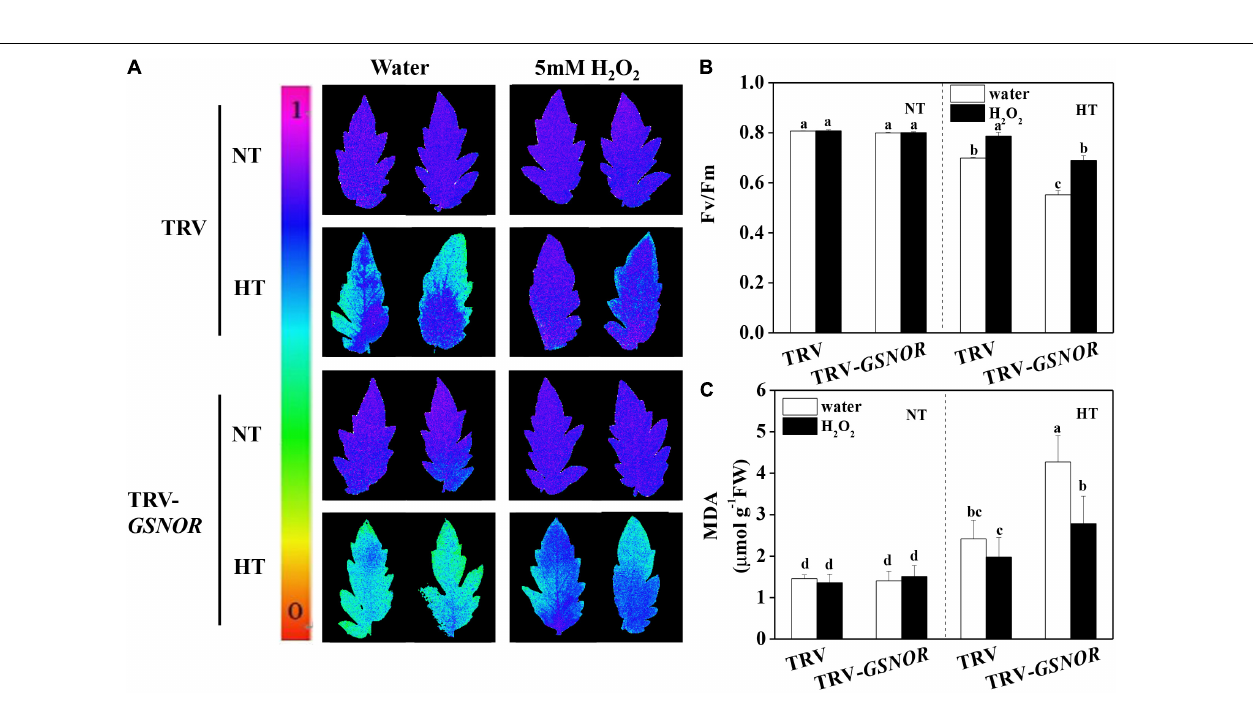
FIGURE 7 | H 2 O 2 recovered the thermotolerance in SlGSNOR1 -silenced plants. (A) Images of the maximum quantum yield (Fv/Fm) of leaves after 24 h exposure to high temperature (42 ◦ C/38 ◦ C) or normal temperature (21 ◦ C/16 ◦ C). The pseudocolor scale at the left side of the image ranges from 0 (black) to 1 (purple); (B,C) Fv/Fm values and malondialdehyde (MDA) content in leaves after 24 h exposure to heat stress. Data are means of five replicates ( ± SD). Means denoted by the same letter did not significantly differ at P < 0.05, according to Tukey’s test. NT, normal temperature; HT, high temperature.